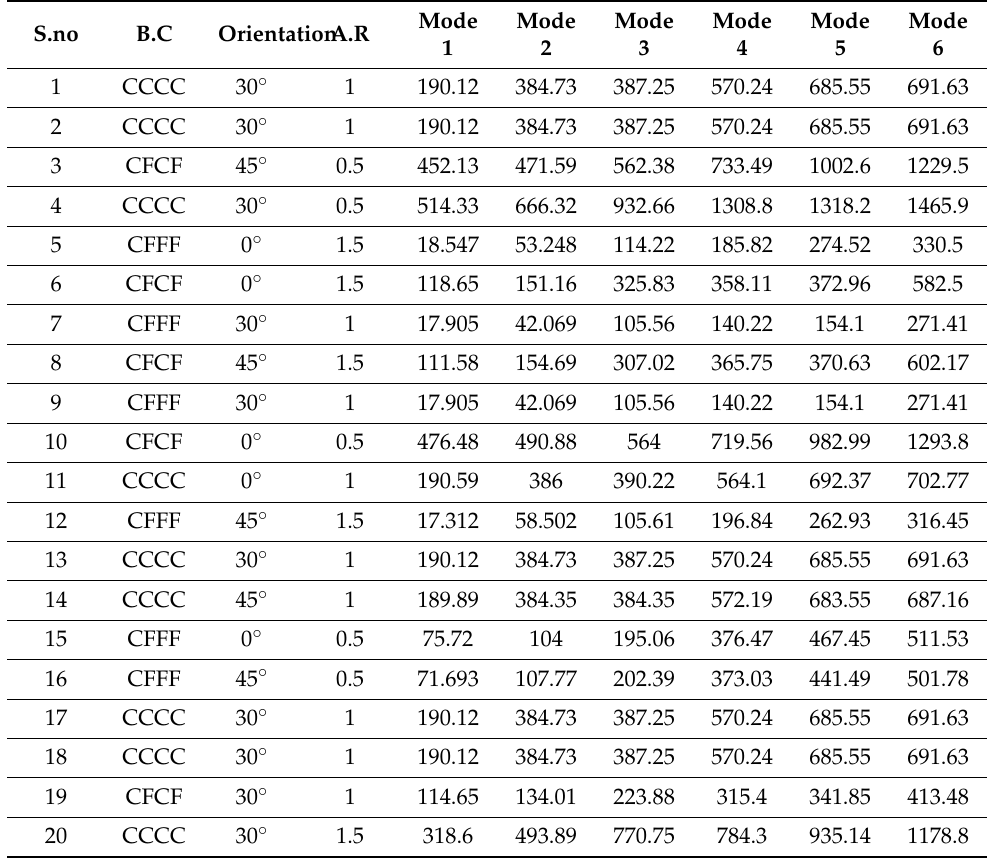
Table 7. Modal analysis results obtained